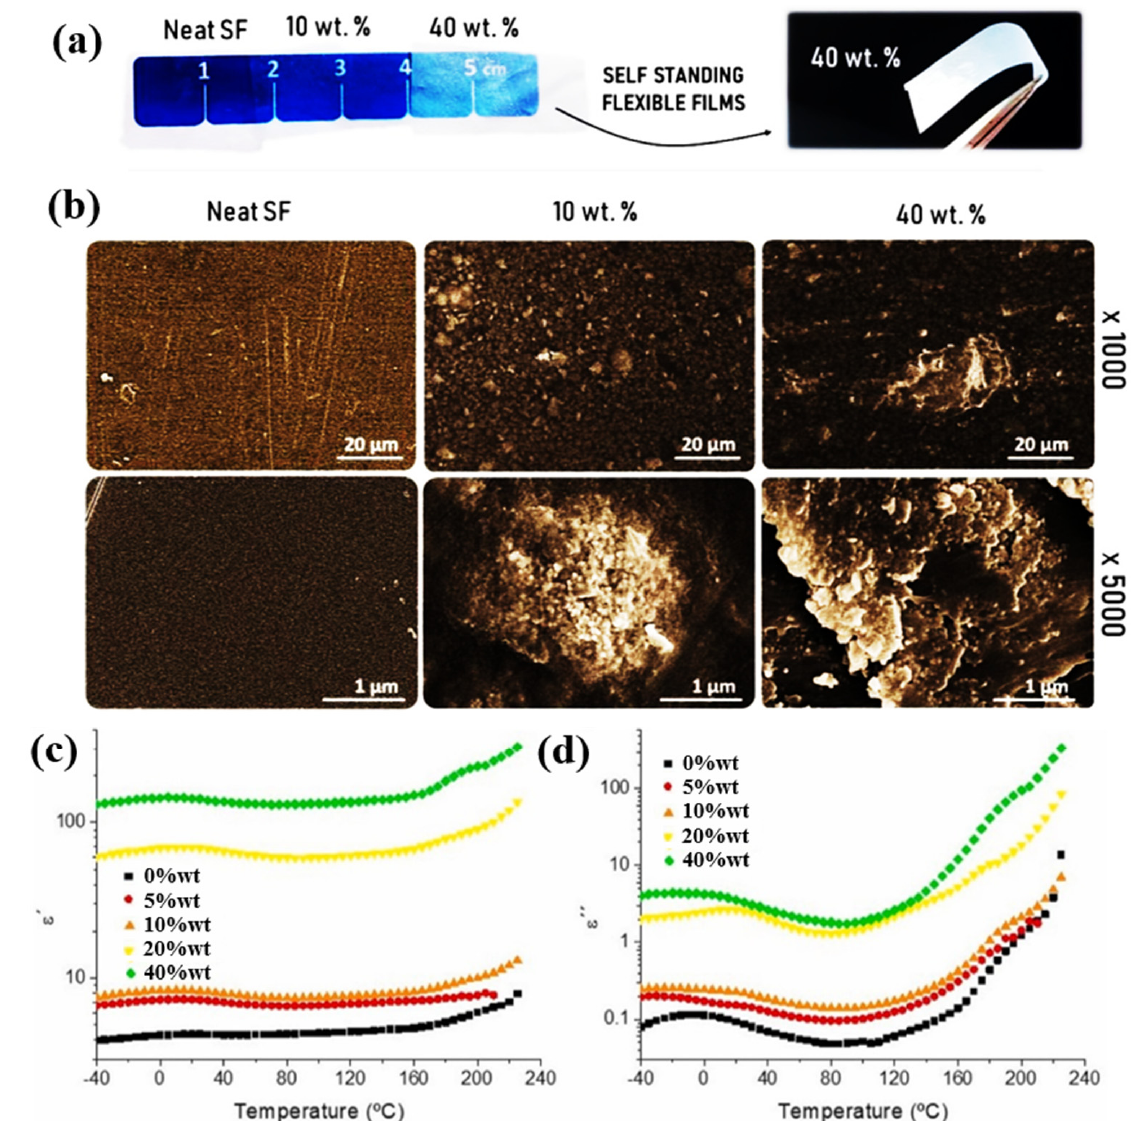
Figure 6. ( a ) Images of flexible silk fibroin/BaTiO 3 composite films. ( b ) Cross-sectional